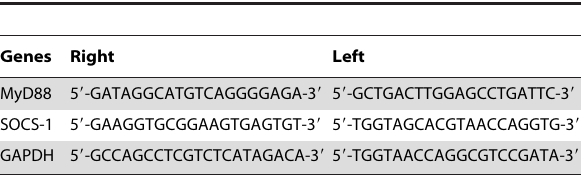
Table 1. Sequence of primer pairs used in semi-quantitative real-time PCR.